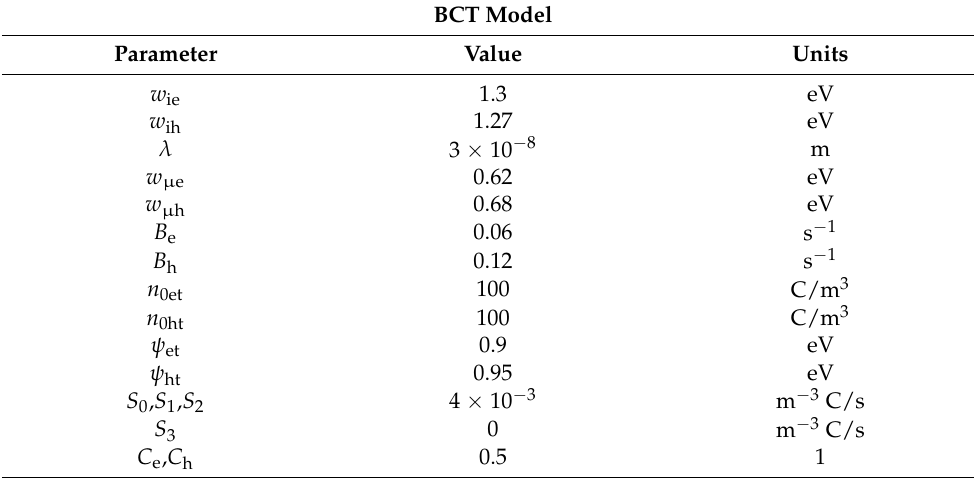
Table 1. The simulation